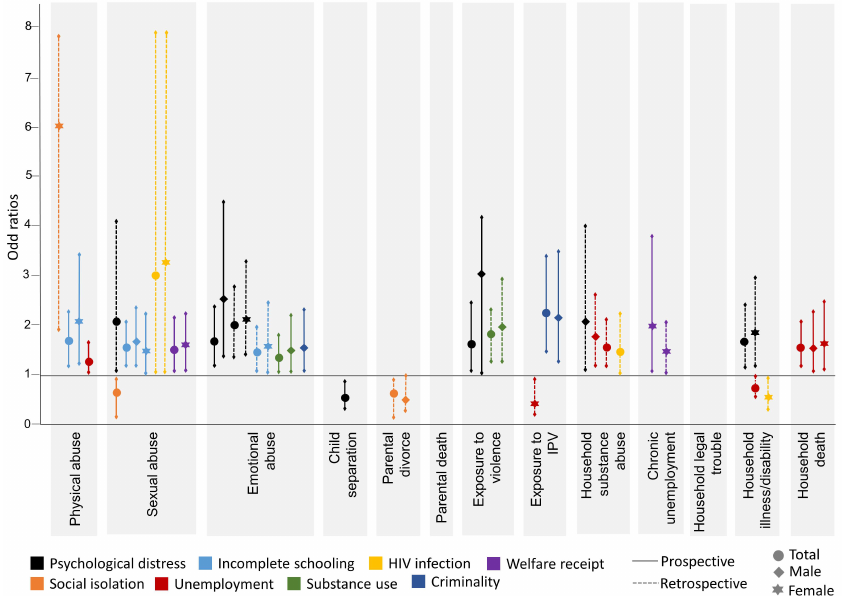
Figure 2. Significant adjusted associations (odds ratios) between single ACEs and human capital outcomes, for the total sample and disaggregated by sex.